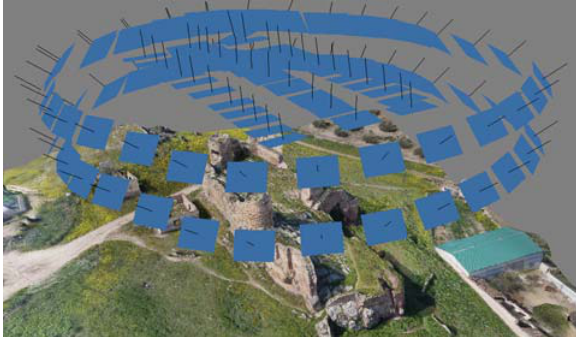
Figure 18. Network geometry at Berrueco Castle (100 images) with Falcon 8.